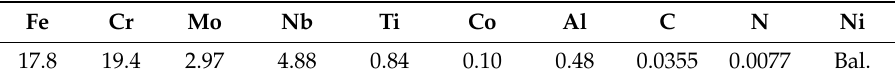
Table 1. Chemical composition of Inconel 718 powder (wt.